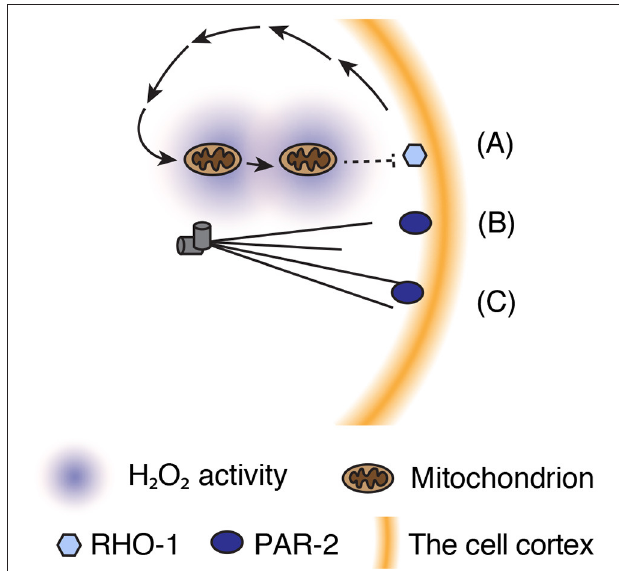
FIGURE 3 | Parallel mechanisms amplify SB to achieve asymmetric patterning of actomyosin and PAR proteins. (A) Asymmetric distribution of mitochondria in the cytosol generates H 2 O 2 gradient, which may oxidize RHO-1 to inhibit its activity. (B) Microtubule binding regulates PAR-2 localization onto the posterior domain. (C) Membrane curvature facilitates PAR-2 cortical localization and concentration at the posterior